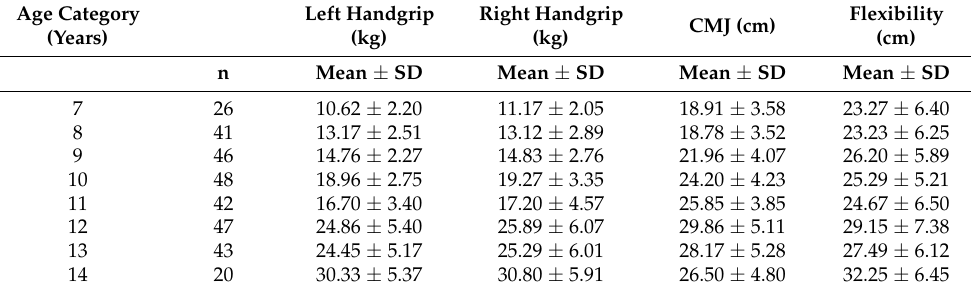
Table 2. Handgrip, flexibility, and counter-movement jump (CMJ).